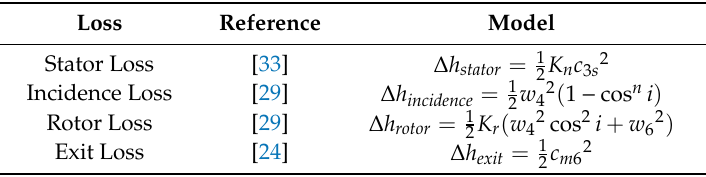
Table 2. The loss model combination of the radial turbine.